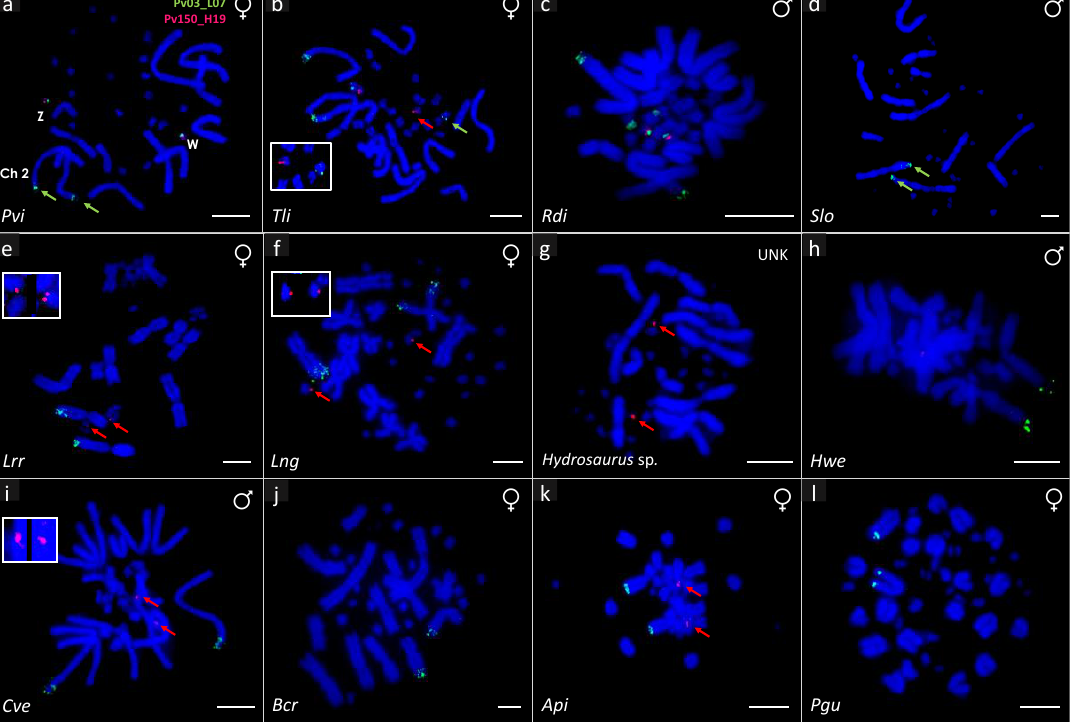
Figure 2. FISH (fluorescence in situ hybridization) using P. vitticeps BAC clones (Pv03_L07 in green and Pv150_H19 in red) on different agamid species. Pvi — P. vitticeps ( a ); Tli — T. lineata ( b ); Rdi — R. diemensis ( c ); Slo — S. loricate ( d ); Api — A. picticauda ( k ); Pgu — P . cf. guttatus ( l ); Cve — C . versicolor ( i );